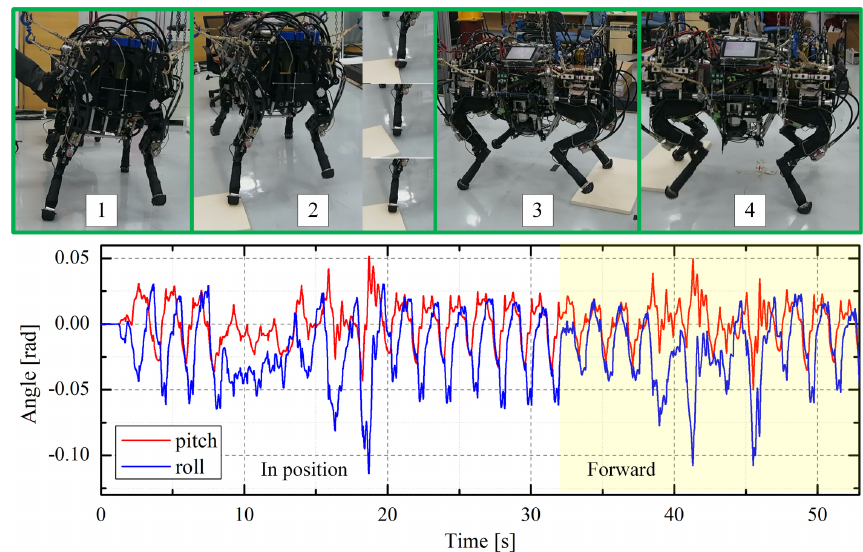
Figure 12. Snapshots of the quadruped walking with unexpected external and terrain disturbances. There are 4 stages of the entire experimental trial. The first 2 stages are the quadruped platform stepped in place with external and terrain disturbances. The quadruped platform walking forward is demonstrated in the last 2